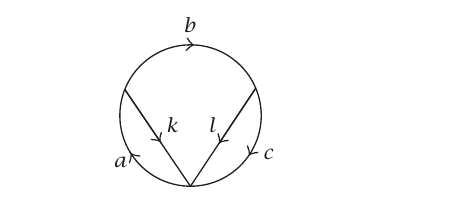
Figure 4.6 . Auxiliary diagrams for partial integrations at length three.